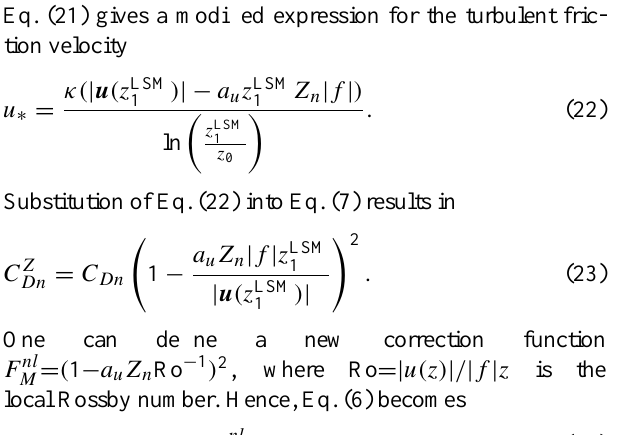
Fig. 11. The dependence of C LES Dn is given by Eq. (23). Symbols and lines are the same as in Fig.